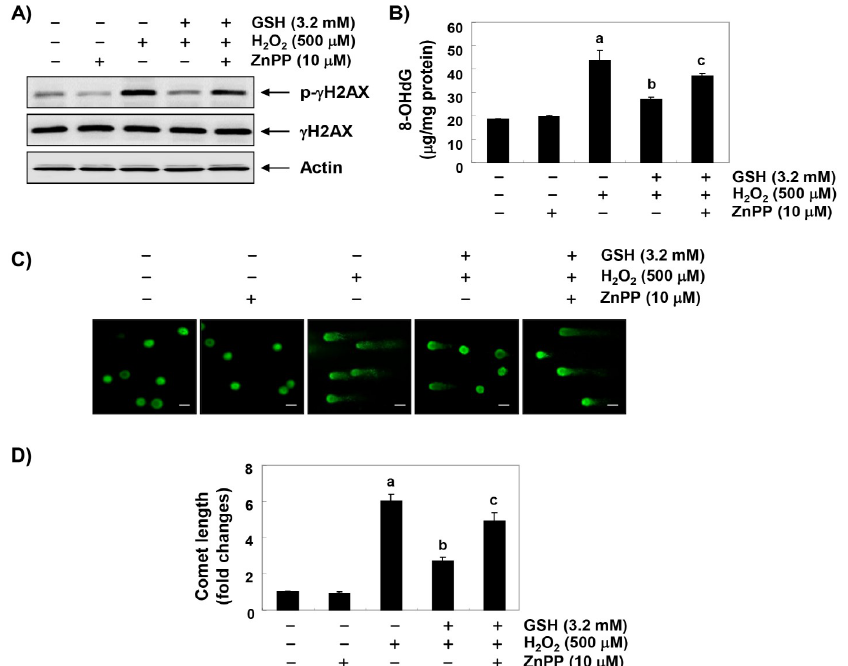
Figure 5. Protection against H 2 O 2 -induced DNA damage by glutathione in RAW 264.7 cells. Cells were pretreated with 3.2 mM glutathione or 10 µ m ZnPP for 1 h and then stimulated with or without 500 mM H 2 O 2 for 24 h. ( A ) The cellular proteins were prepared, and p- γ H2AX and γ H2AX protein levels were assayed by Western blot analysis using an ECL detection system. Actin was used as an internal control. ( B ) The amount of 8-OHdG in the DNA was determined using an 8-OHdG-EIA kit. The measurements were made in triplicate, and values are expressed as the mean ± SD ( a p < 0.05 compared with the control group; b p < 0.05 compared with the H 2 O 2 -treated group; and c p < 0.05 compared with the glutathione- and H 2 O 2 -treated group). ( C , D ) The comet assay was performed, representative images of the comet assay were taken by a fluorescence microscope (original magnification, × 200, Scale bar, 40 µ m) and the comet length (fold of control) was quantified ( a p < 0.05 compared with the control group; b p < 0.05 compared with the H 2 O 2 -treated group; and c p < 0.05 compared with the glutathione- and H 2 O 2 -treated group).